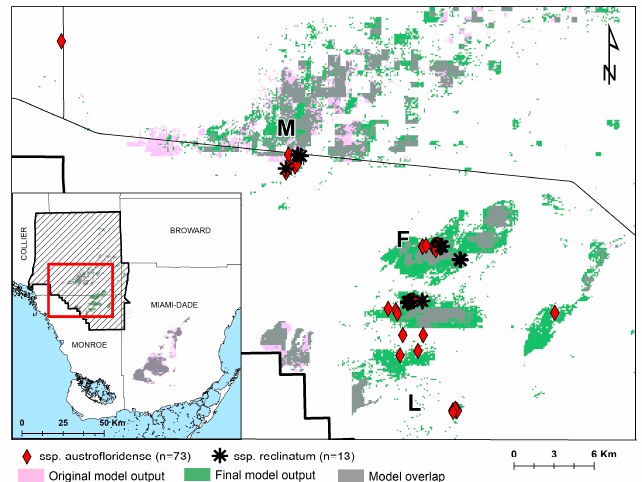
Figure 2. Approximate locations of Sideroxylon reclinatum s.l. found during the study that were identified to subspecies. Subsp. austrofloridense is represented by red diamonds and subsp. reclinatum is represented by black asterisks. Green polygons represent the final HSM model output for focal areas of BICY (map, extent represented by red square in inset) and for the entire study area (inset). BICY boundary is represented as black crosshatch in the inset. Landmarks discussed in results are displayed on the map: M = Monument Lake, F = Frog Hammock, L = Lostmans